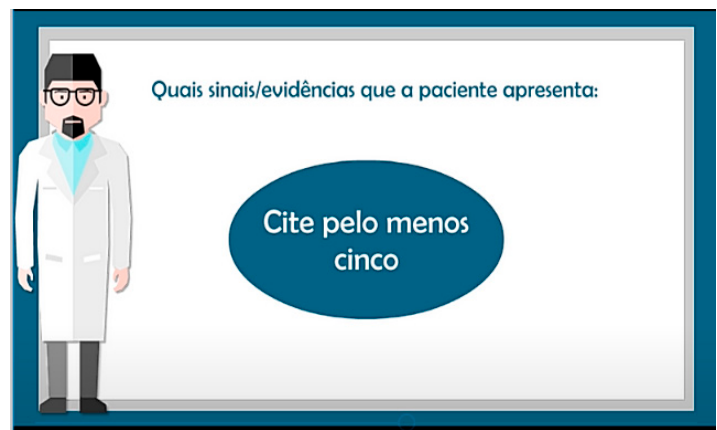
Figure 3. Assessing spiritual needs (table content explained in English in the text).